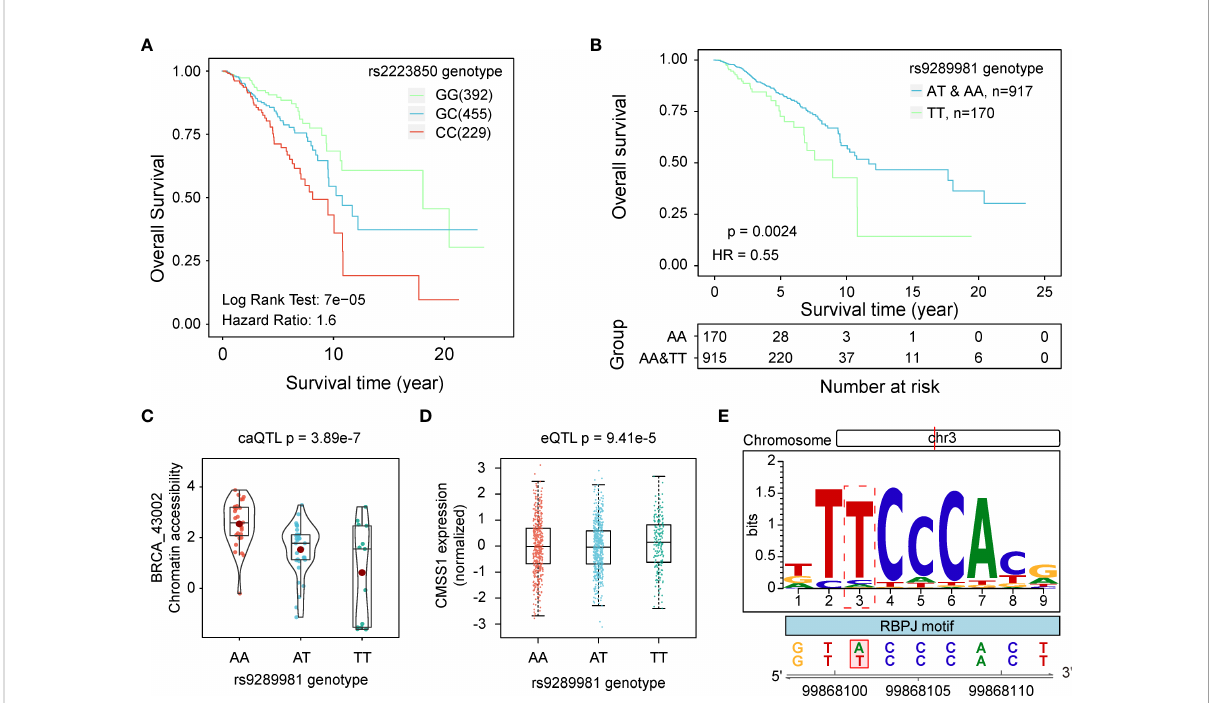
FIGURE 6 caQTLs related to survival time. (A) KM curves show the difference in survival time of patients with different genotypes of rs2223850. (B) KM curves show the difference in survival time of patients with different genotypes of rs9289981 in the dominant model. Patients in the TT genotype group showed a poor prognosis. (C) Distribution of chromatin accessibility of BRCA_43002 in groups with different genotypes of rs9289981. (D) Distribution of expression of CMSS1 in groups with three different genotypes of rs9289981. (E) Potential disruption of rs9289981 on the binding site of RBPJ